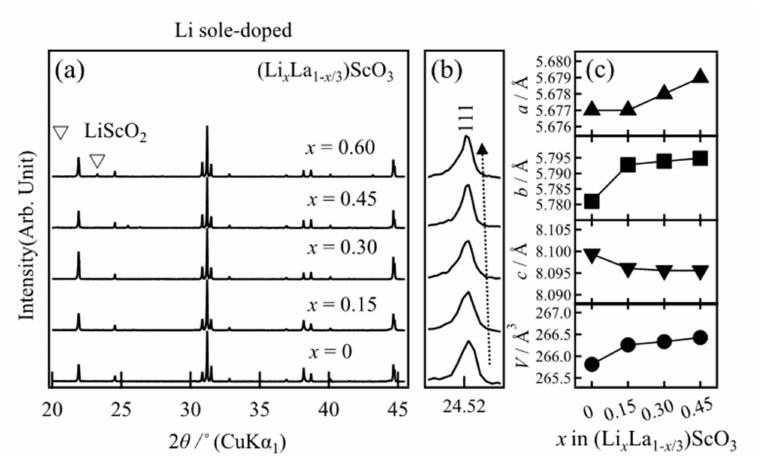
Figure 1. ( a , b ) X-ray diffraction patterns and ( c ) dependence of the lattice parameters on the com- position of (Li x La 1 − x/3 )ScO 3 ( x = 0, 0.15, 0.30, 0.45). Lattice parameter data for LaScO 3 ( x = 0) were taken from the literature